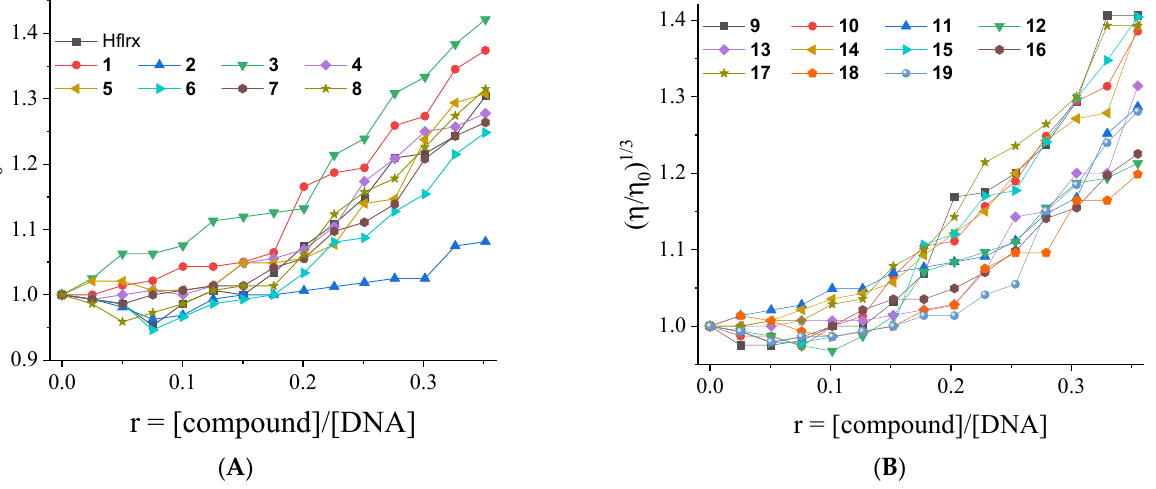
Figure 7. Relative viscosity ( η / η 0 ) 1/3 of CT DNA (0.1 mM) in buffer solution (150 mM NaCl and 15 mM trisodium citrate at pH 7.0) in the presence of complexes ( A ) 1 – 8 and ( B ) 9 – 19 at increasing amounts ( r = [compound]/[DNA] ratio= 0–0.35).